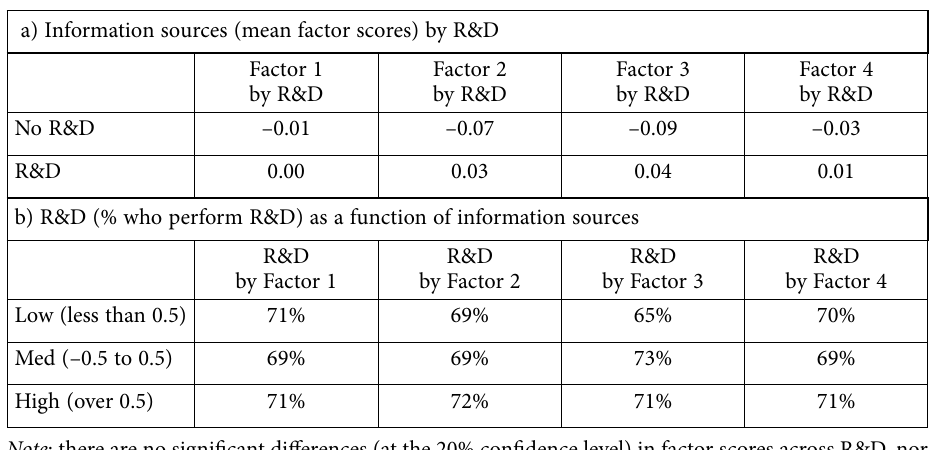
Table 3. Relationship between information sources and